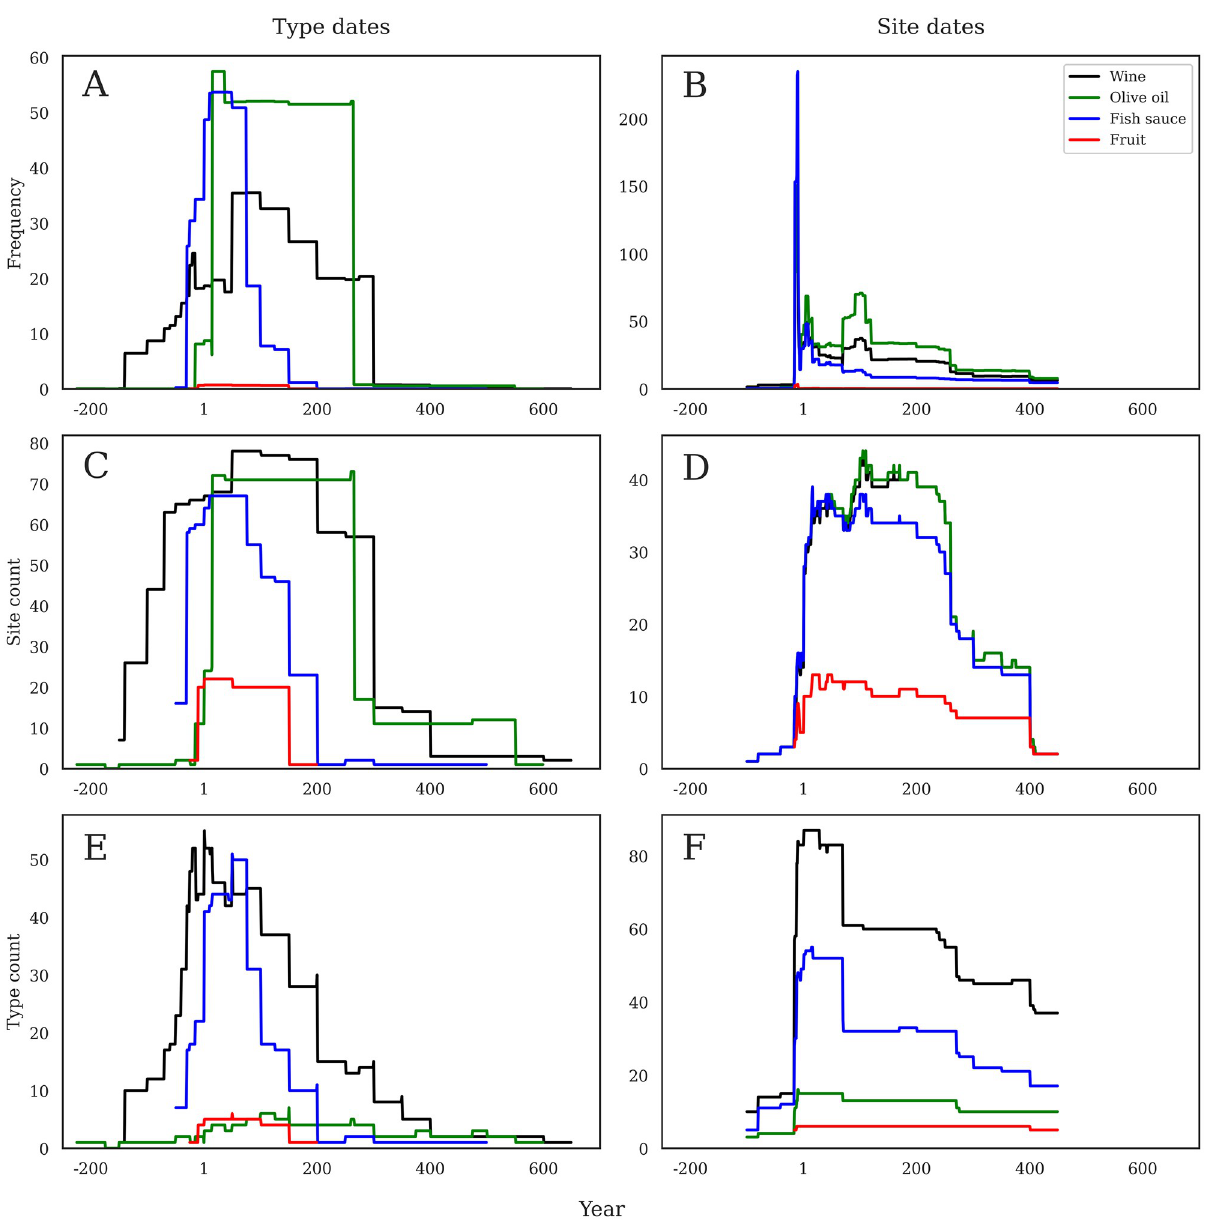
Fig 6. a-f. Amphora contents through time. Comparison of six main amphora-borne foodstuffs across the three different methods of analysis according to production dates (left) and consumption dates (right). Note that Y axes are not constant.